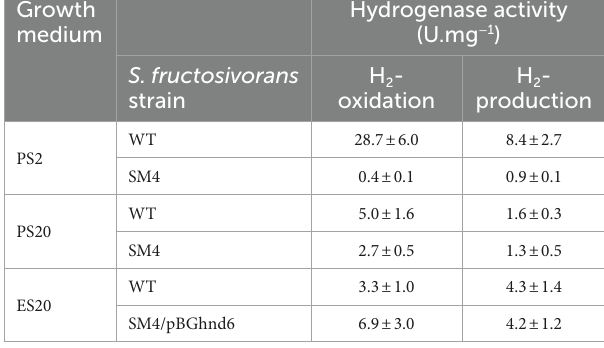
TABLE 1 Hydrogenase activity in S. fructosivorans